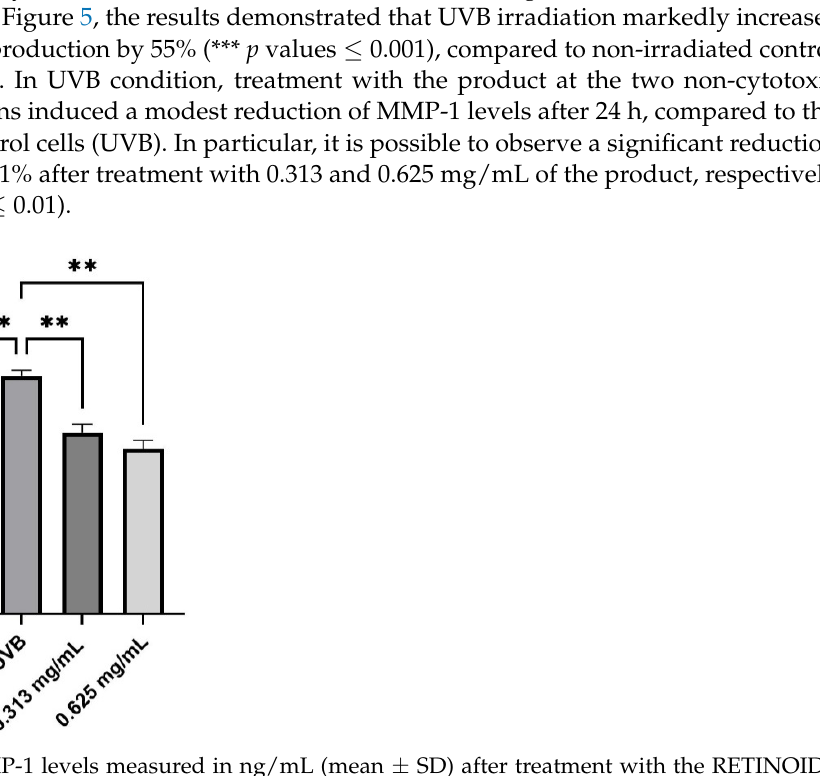
Figure 5. MMP-1 levels measured in ng/mL (mean ± SD) after treatment with the RETINOIDS SERUM at the concentrations of 0.313 and 0.625 mg/mL in HaCaT cells. CTRL: untreated cells; UVB: irradiated cells. Values of ** p < 0.01 and *** p < 0.001 were considered statistically significant.